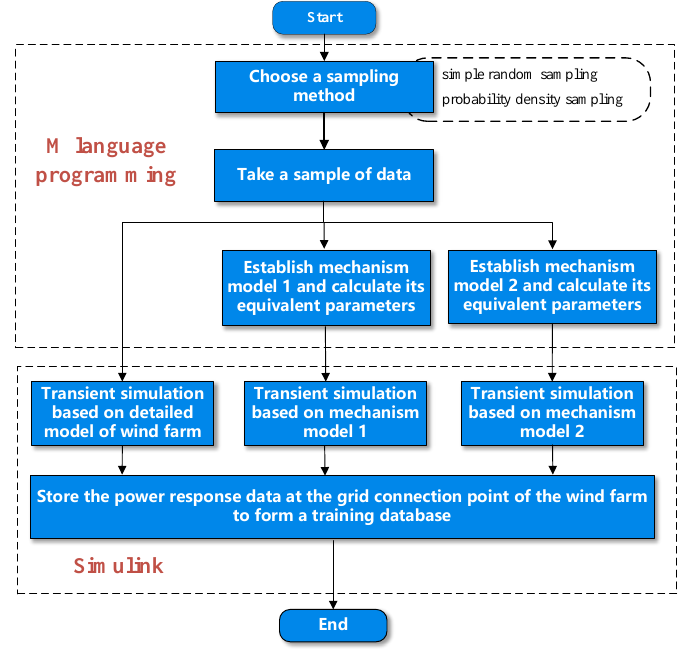
Figure 2. Training database construction flowchart.